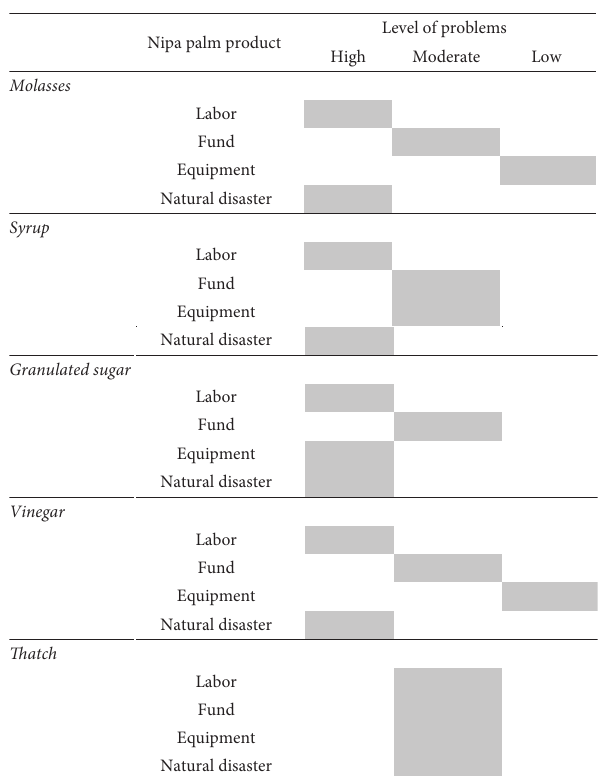
Table 2: The level of nipa palm product